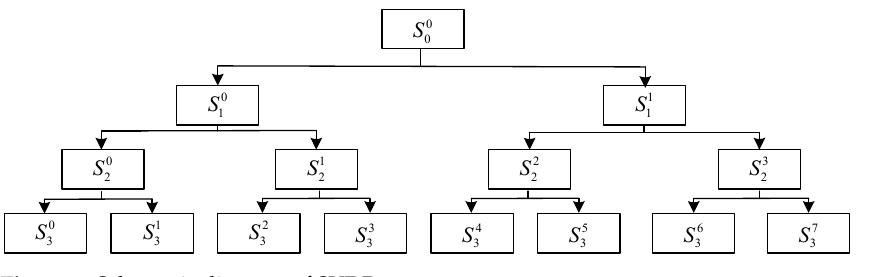
Figure 1. Schematic diagram of